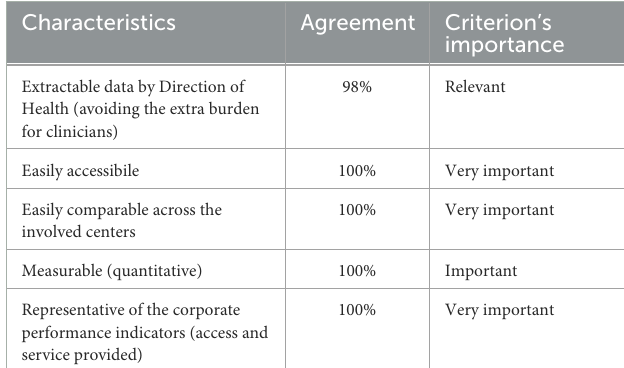
TABLE 1 Criteria for the choice of